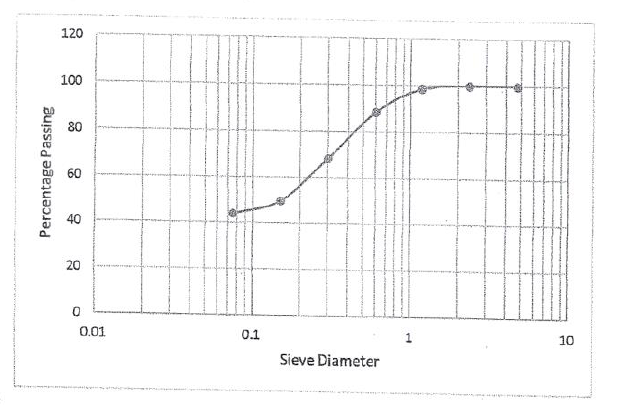
Figure 7: Graph of Dry Density against Average Moisture Content